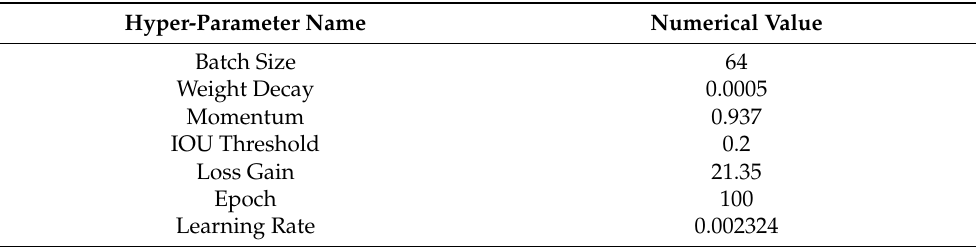
Table 4. Hyper-parameter